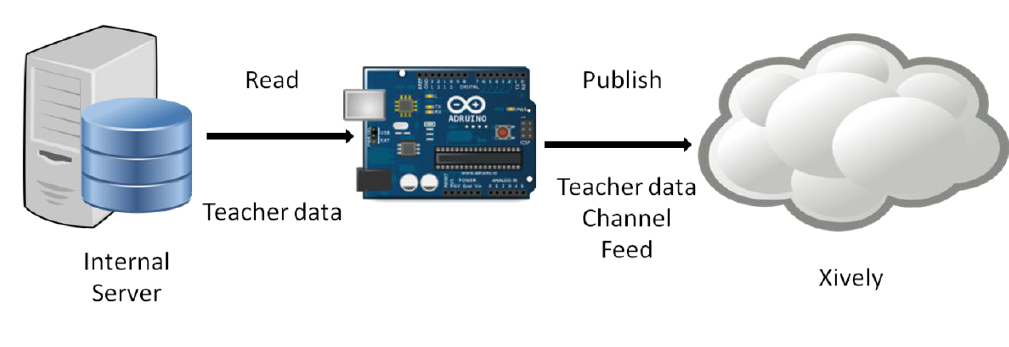
Figure 8. Putting data in the